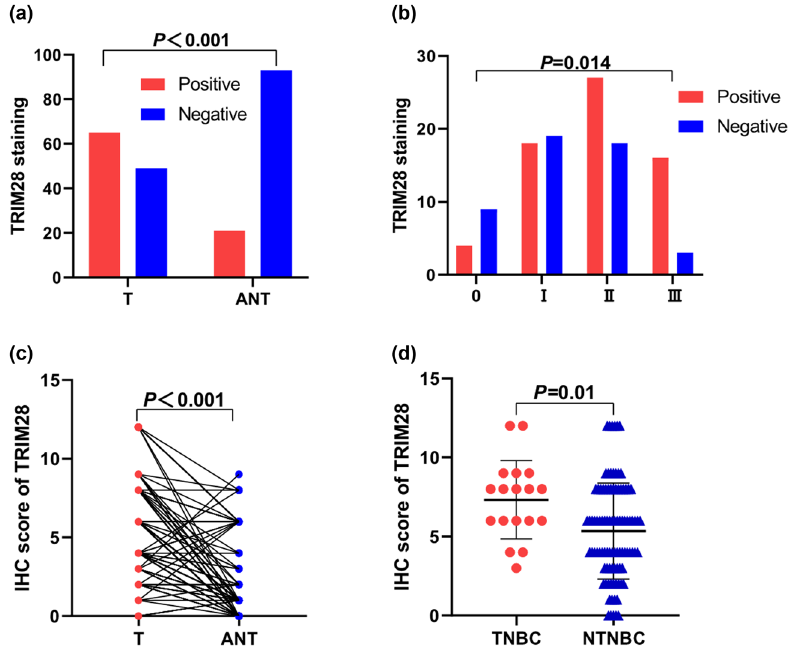
Figure 2: The IHC staining of TRIM28 expression in tissues. ( a ) The comparison of the percentage of positive TRIM28 staining in tissues between tumors and ANTs ( P < 0.001 ) . ( b ) The distribution of positive TRIM28 staining at di ff erent TNM stages ( P = 0.014 ) . ( c ) The IHC score of TRIM28 in cancer and adjacent tissues ( P < 0.001 ) . ( d ) The IHC score of TRIM28 in triple - negative breast cancer and non - triple - negative breast cancer ( P = 0.01 ) . ANT: adjacent normal tissue; T: tumor; TNBC: triple - negative breast cancer; NTNBC: non - triple - negative breast cancer.